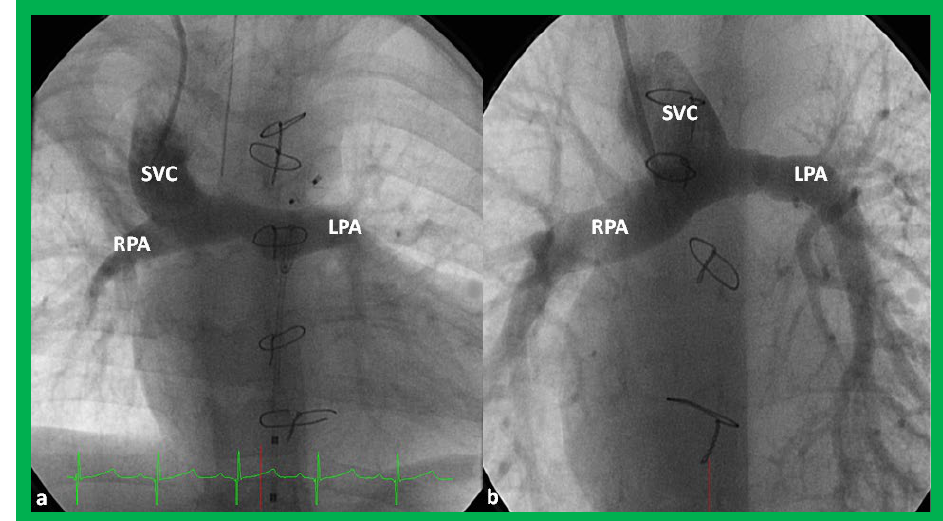
Figure 29. Selected cine frames in postero–anterior ( a ) and sitting up ( b ) views, demonstrating bidirectional Glenn procedure (the superior vena cava [SVC] is anastomosed with the right pulmonary artery [RPA]) in two different patients during Stage II of Fontan procedure. Unobstructed flow from the SVC to the right (RPA) and left (LPA) pulmonary arteries is shown. Reproduced from Rao PS, Indian J Pediatr 2015; 82:1147–1156 [36].